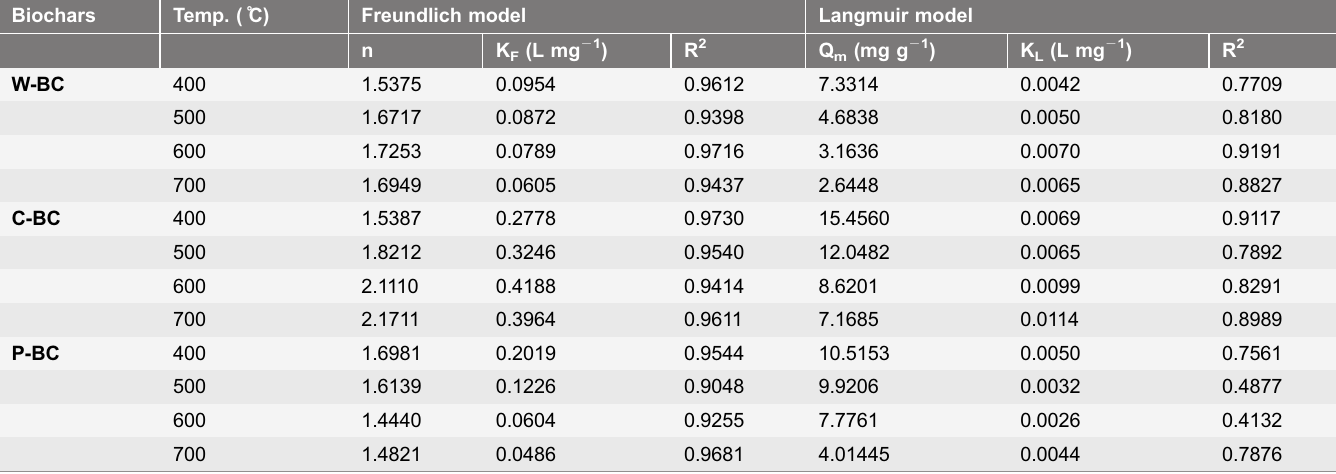
Table 4. Regression parameters of isotherms for expressing adsorption of solution NH 4 + -N to W-BC, C-BC and P-BC at different pyrolytic temperatures.